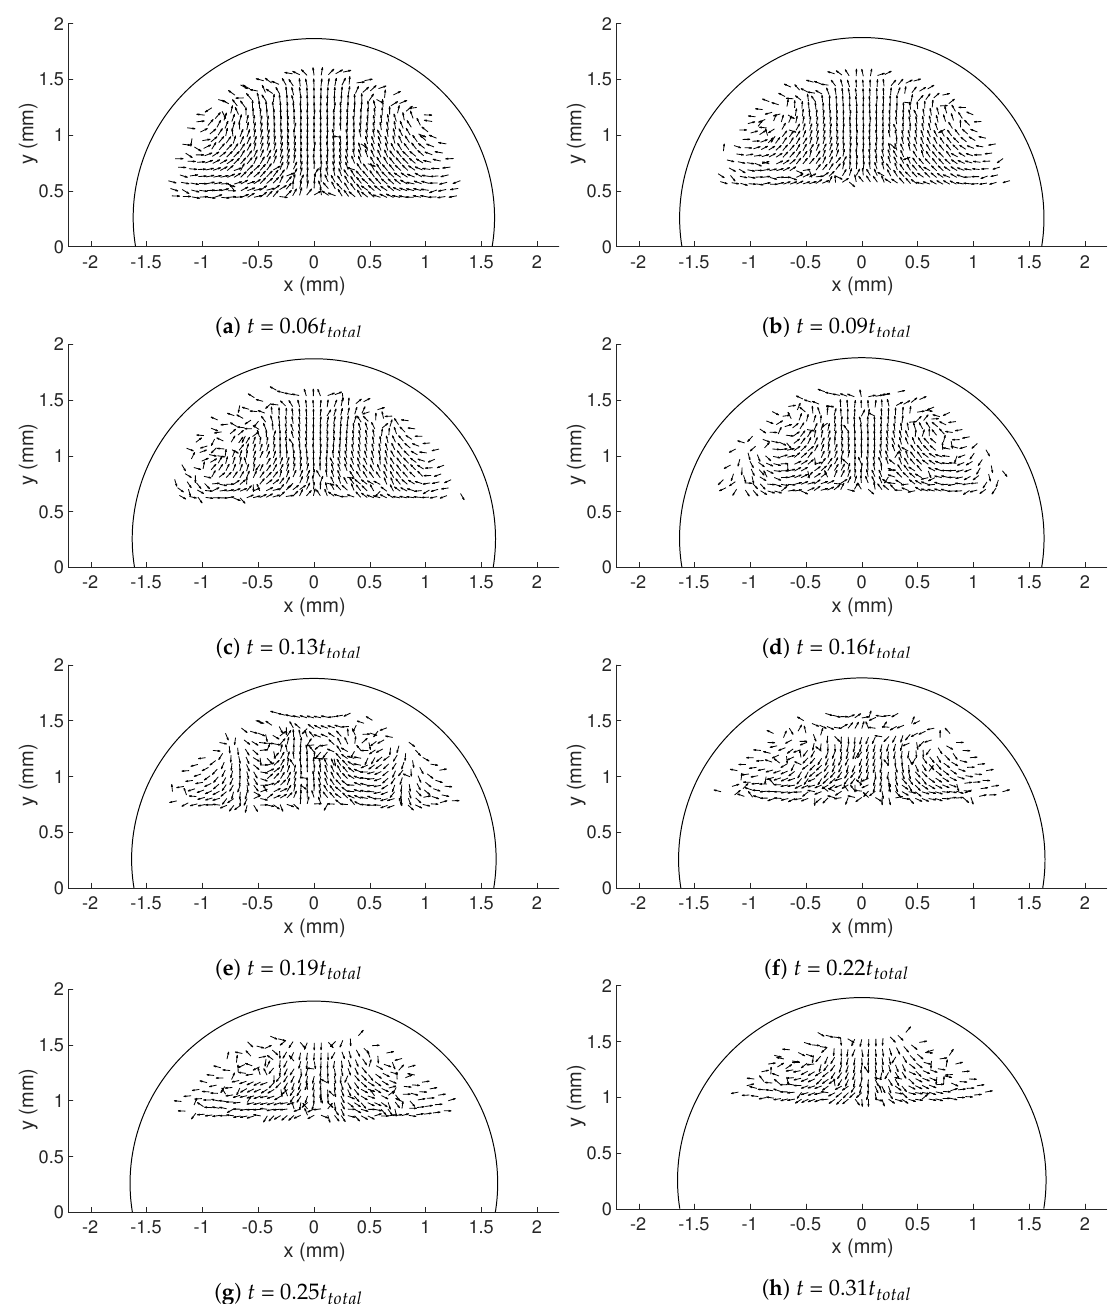
Figure 11. Internal flow patterns with normalized velocity vectors for the corrected data when T plate = 261.15 K at t = 1–5